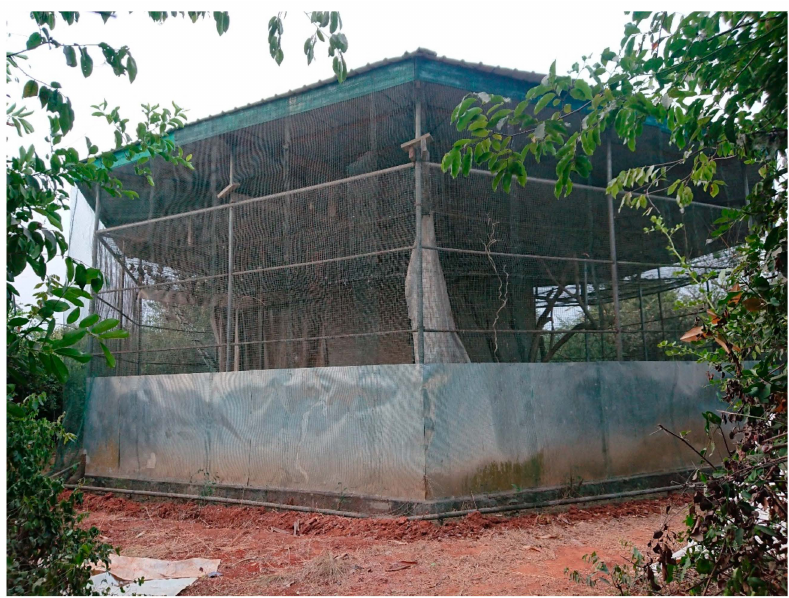
Figure 1. Cage housing the Eidolon helvum bat colony. The mesh double-walls, ground-level cladding and outer solid roof are clearly visible. Note, the bat colony can be seen roosting while hanging from the inner mesh roof towards the left side of this